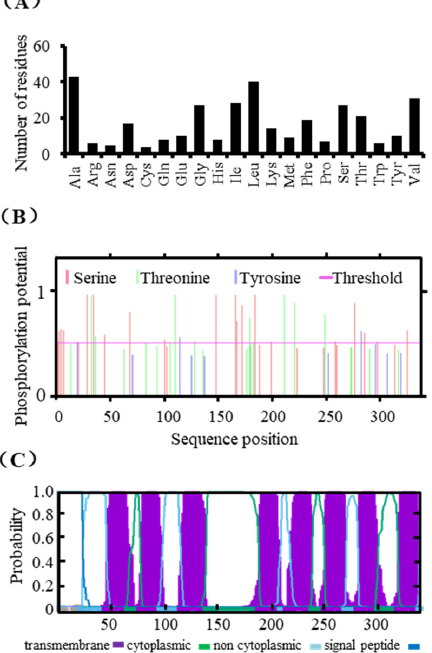
Figure 2. Sequence characterization and transmembrane region prediction of SpZIP2. ( A ) Amino acid composition analysis for SpZIP2. ( B ) Prediction of protein phosphorylation sites for SpZIP2. ( C ) Transmembrane region prediction of SpZIP2.